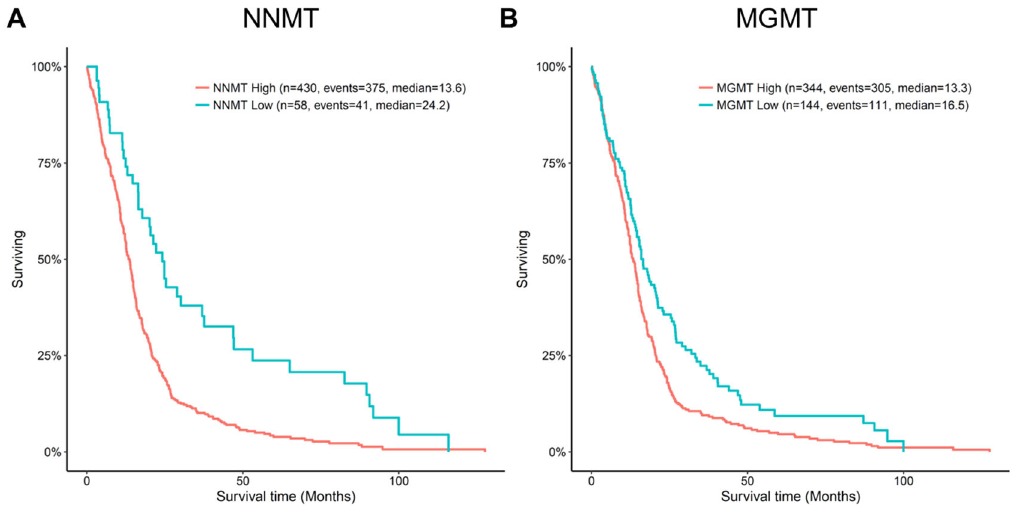
Figure 2. Kaplan Meier curves of NNMT and MGMT microarray-based expression. High expression of either gene is associated with poor survival with a Wilcoxon p value of 1 × 10 − 4 and 7.1 × 10 − 3 for NNMT and MGMT, respectively. Data was obtained and visualized using the TCGA-GBM study Agilent-4502A microarray data. Optimal cutoff points for survival curves were determined using the survminer package, − 1.93 and − 1.39 for NNMT and MGMT, respectively. Visualization and statistics of this data were prepared using http://gliovis.bioinfo.cnio.es/ (accessed on 1 May 2022) [64].